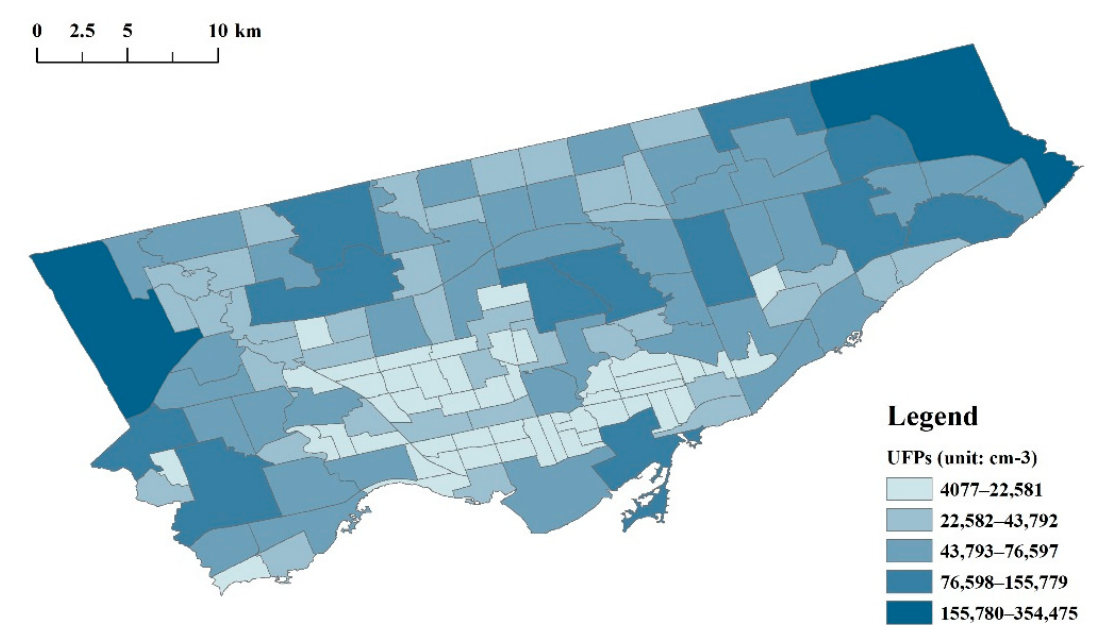
Figure A12. Distribution of ultrafine particles (UFPs).